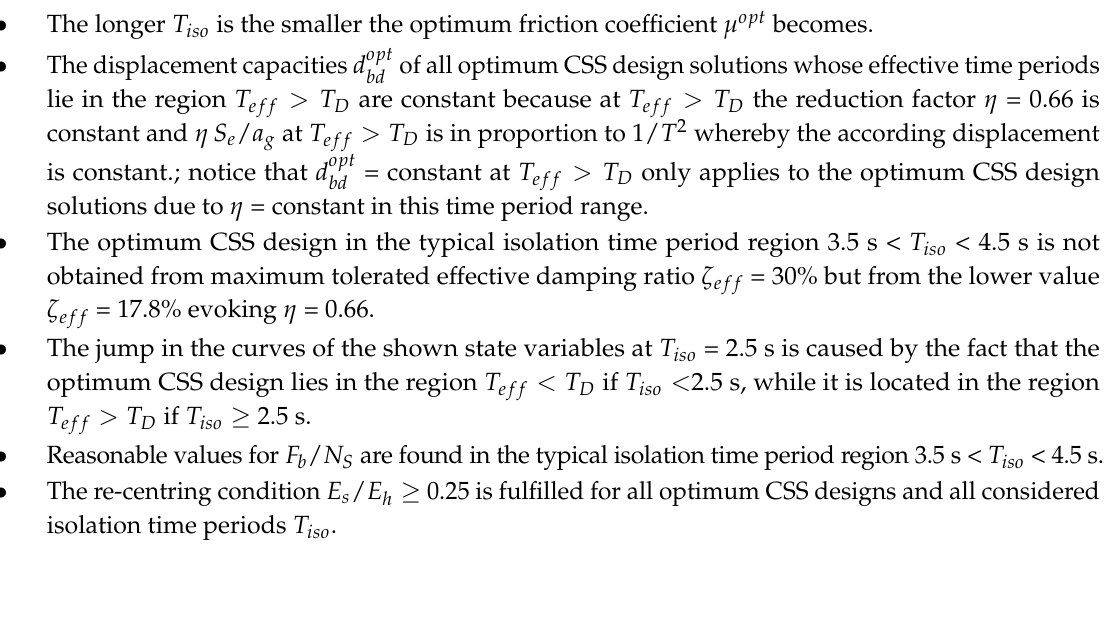
Figure 7. ( a ) Optimization trajectory for T iso = 2.5 s and ( b ) according close-up for spectrum type 1 with soil class C.